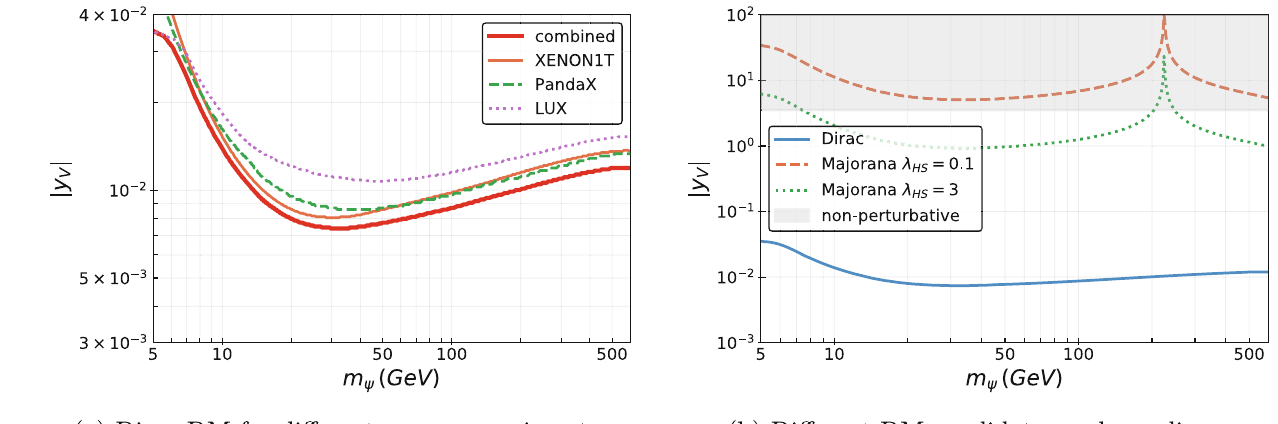
Fig. 5 DM direct detection 90% C.L. limits with a vector-like fermion in the loop. We fix m S = 500 GeV, m F = 600 GeV, the ratio of Yukawa couplings | y A | / | y V | = 1 . 3 and the phases of the Yukawa couplings are